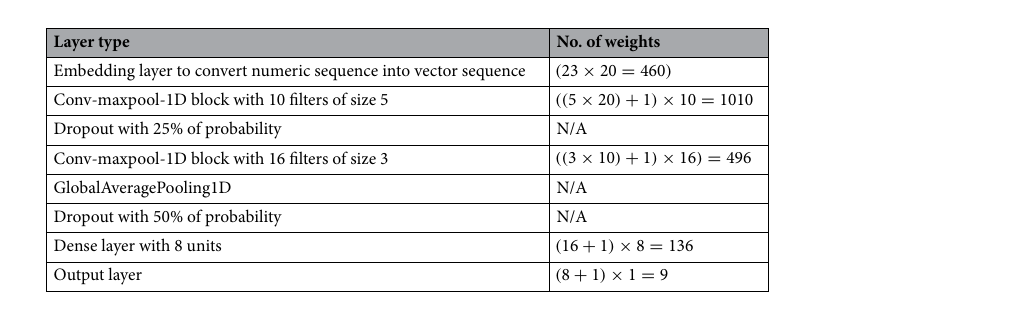
Figure 12. CNN architecture to identify CarboxE sites.